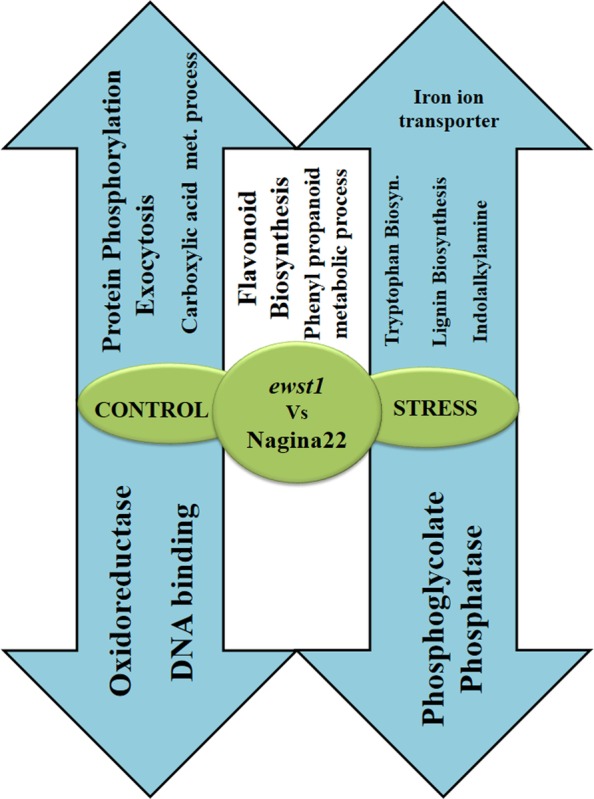
Alterations in biological pathways in the mutant revealed by GO analysis (arrows in the upper and lower direction indicate pathways induced by up-regulated and down-regulated URDEGs, respectively; pathways given in the left, right and middle are altered under control, stress and also both control and stress conditions, respectively).